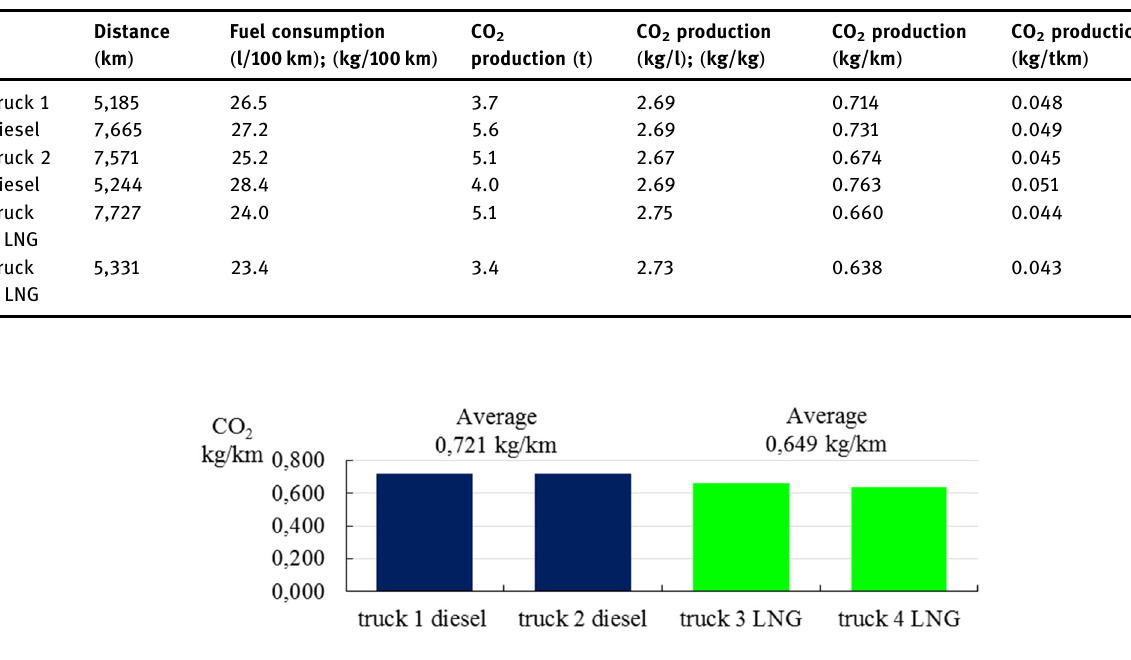
Figure 6: CO 2 production per 1 km for trucks with